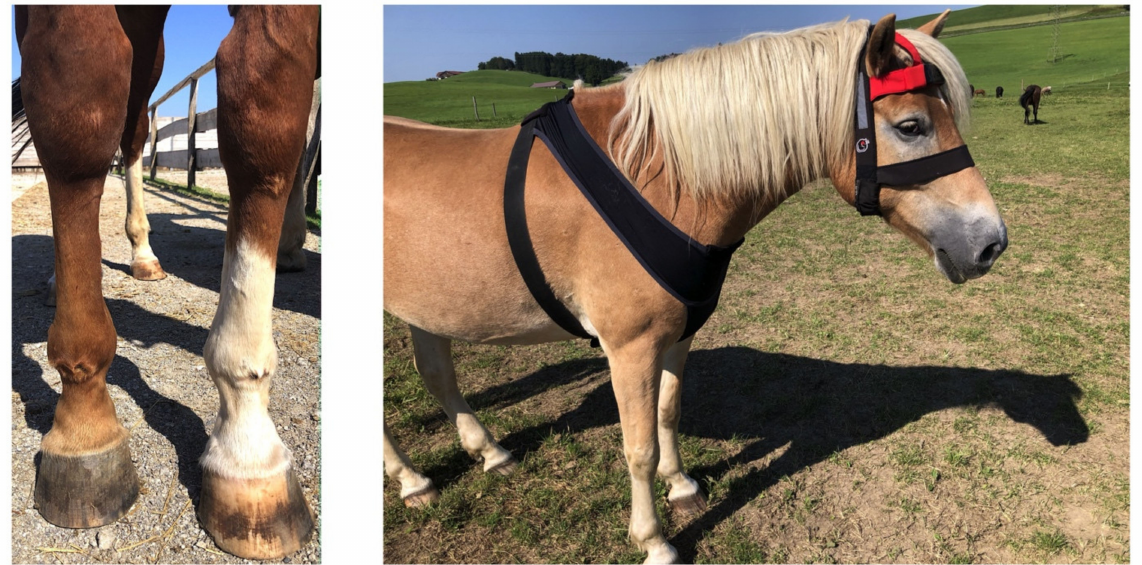
Figure 1. The photograph on the left shows the pathognomonic skin lesions over the dorsal aspect of both metacarpopha- langeal (fetlock) joints and carpi of a horse with chronic REM deficit. The photograph on the right displays a horse equipped with the automated equine monitoring system (Trackener ® ) in the lycra